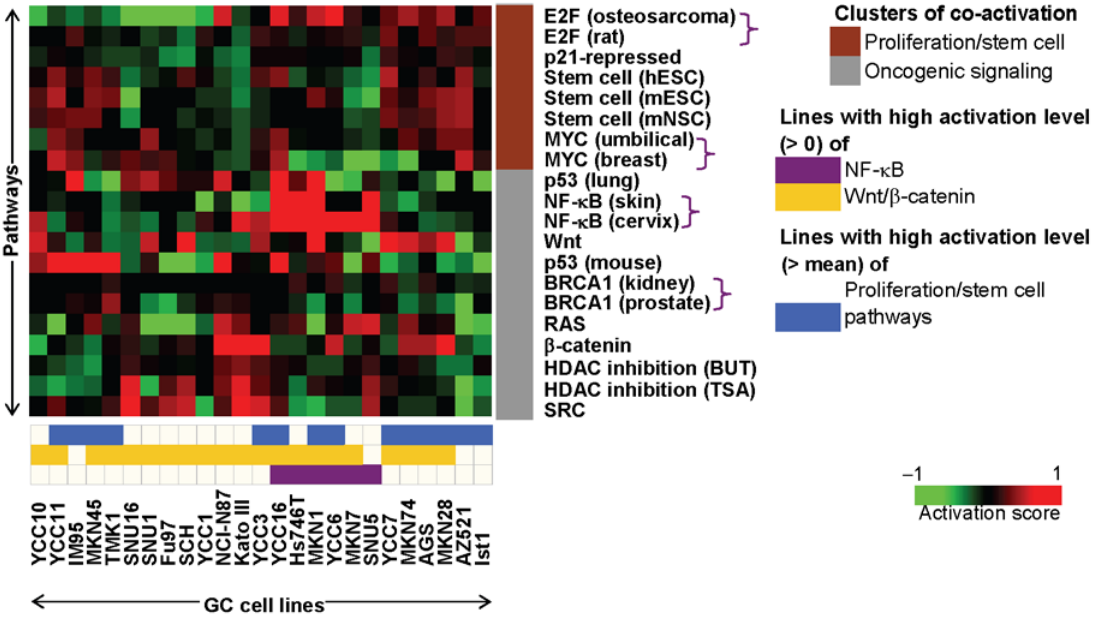
Figure 3. Patterns of pathway activation in gastric cancer cell lines. Twenty gene expression signatures representing 11 cancer-related pathways (previously described in Figure 2) were queried against a panel of 25 gastric cancer cell lines. The heatmap depicts the activation scores of pathways represented by the signatures (rows) in individual cell lines (columns), with red squares denoting higher activation scores. Pathways and cell lines were ordered using unsupervised hierarchical clustering. Similar to primary tumors, pathways related to proliferation or stem cell form a distinct cluster (brown) from other pathways (grey). Cell lines with high predicted activation of NF- k B, Wnt/ b -catenin, or proliferation/stem cell- related pathways are indicated by relevant color bars at the bottom of the heatmap. For the proliferation/stem cell-related signatures, the cell lines were mean-normalized relative to one another against the mean activation score, as all cell lines scored positive for proliferation/stem cell-related pathways.